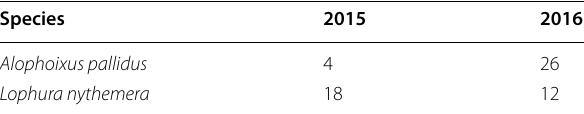
Table 1 List of bird species captured by motion sensor